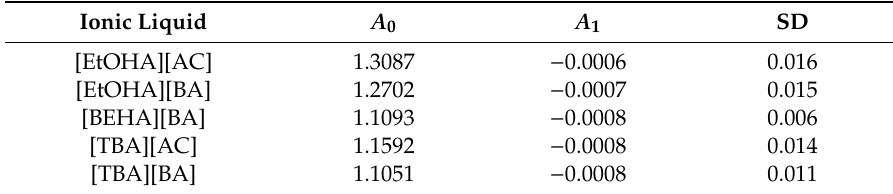
Table 4. Fitting parameters of Equation (3) for density ( ρ ) correlation and standard deviation (SD) from Equation (5).